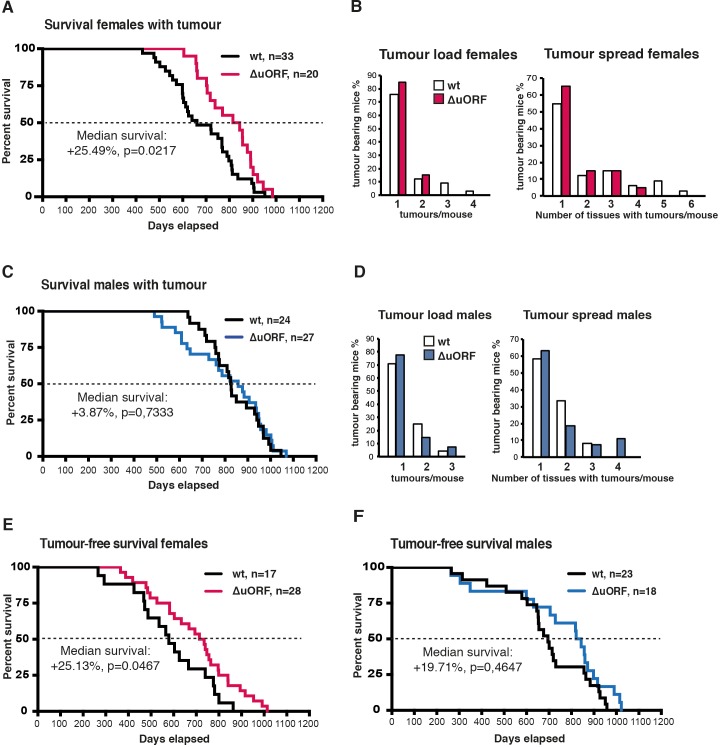
Analysis of tumour related survival, and tumour load and spread.(A) Survival curves of wt and C/EBPβΔuORF tumour-bearing female mice. (B) At the left, tumour load in wt and C/EBPβΔuORF females as determined by the number of different tumour types found per tumour bearing mouse. At the right, tumour spread in wt and C/EBPβΔuORF females as determined by the number of tissues affected by tumours in tumour bearing mice irrespective of the tumour type (in case different tumour types were found in the same tissue it was counted as >1). (C) Survival curves of wt and C/EBPβΔuORF tumour-bearing male mice. (D) At the left tumour load and at the right tumour spread in wt and C/EBPβΔuORF males as described under (C). (E) Survival curves of wt and C/EBPβΔuORF tumour-free female mice. (F) Survival curves of wt and C/EBPβΔuORF tumour-free male mice. For survival curves the increase in median survival (%) of the C/EBPβΔuORF compared to wt mice and statistical significance of the increase in the overall survival as determined by the log-rank test is indicated in the figure.